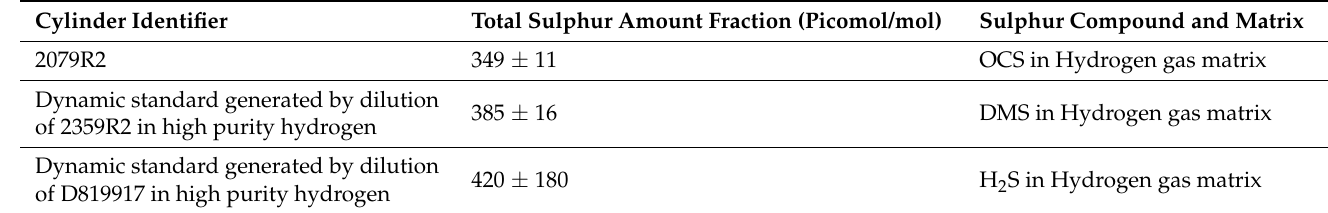
Table 3. Reference value for the certified standard used in the trueness